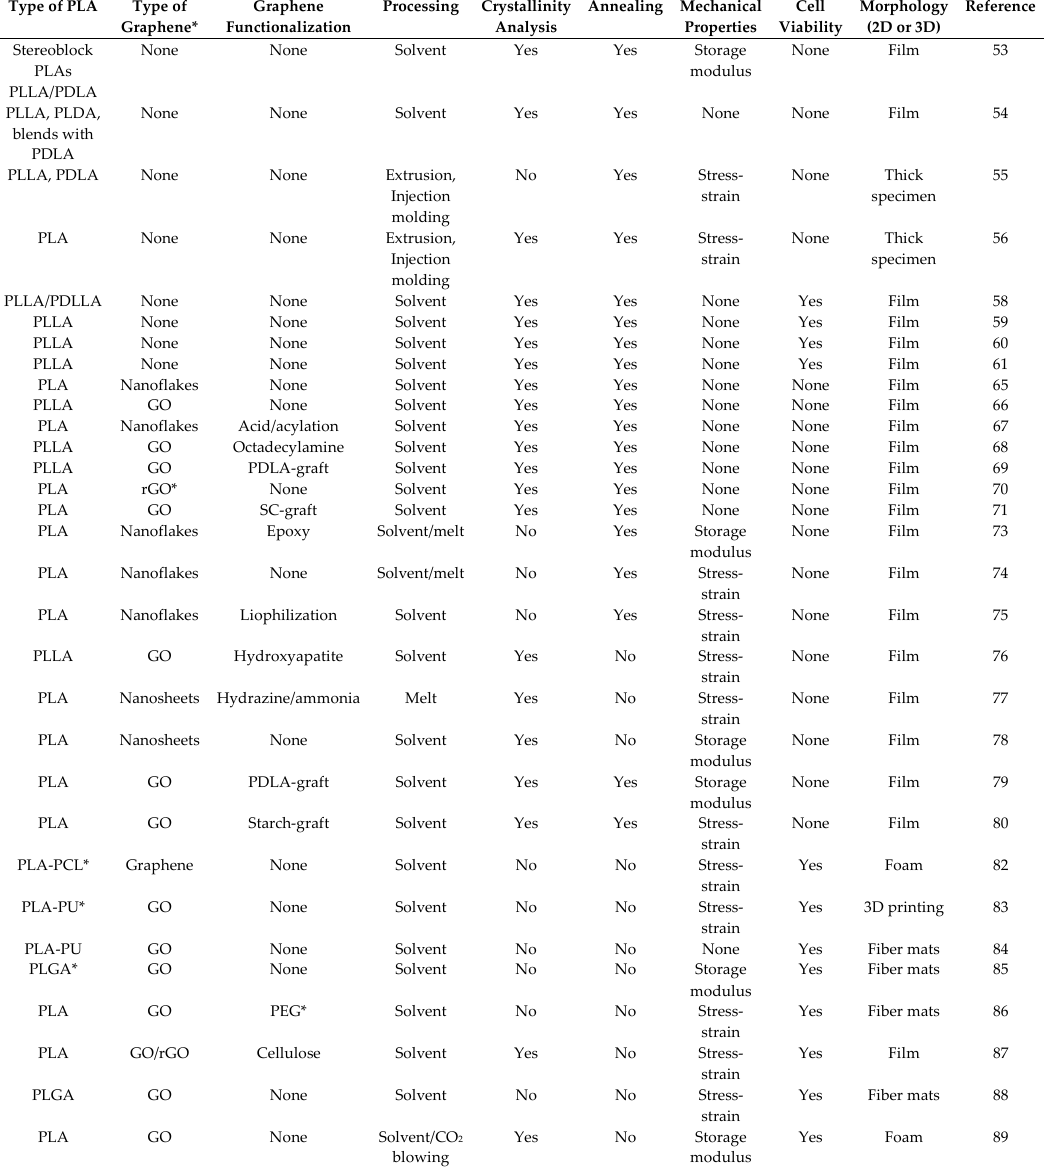
Table 1. Summary of literature reviewed. The table lists the type of PLA polymer and graphene used as well as the processing conditions and characterization methods employed.